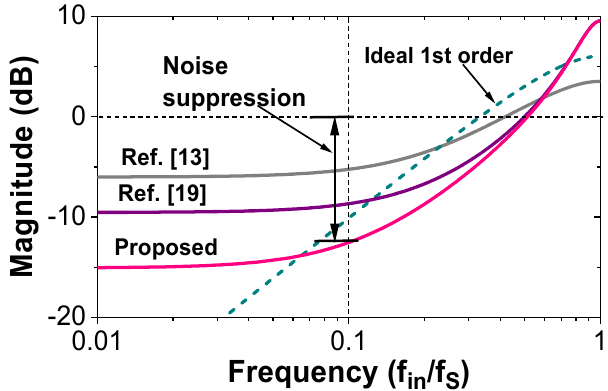
Figure 6. Calculated NTF as a function of normalized frequency.